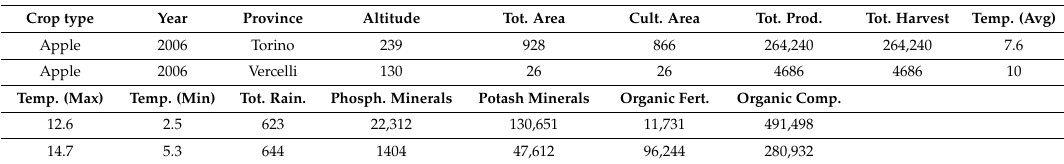
Table 1. Details about culture time-series in the Istat dataset.